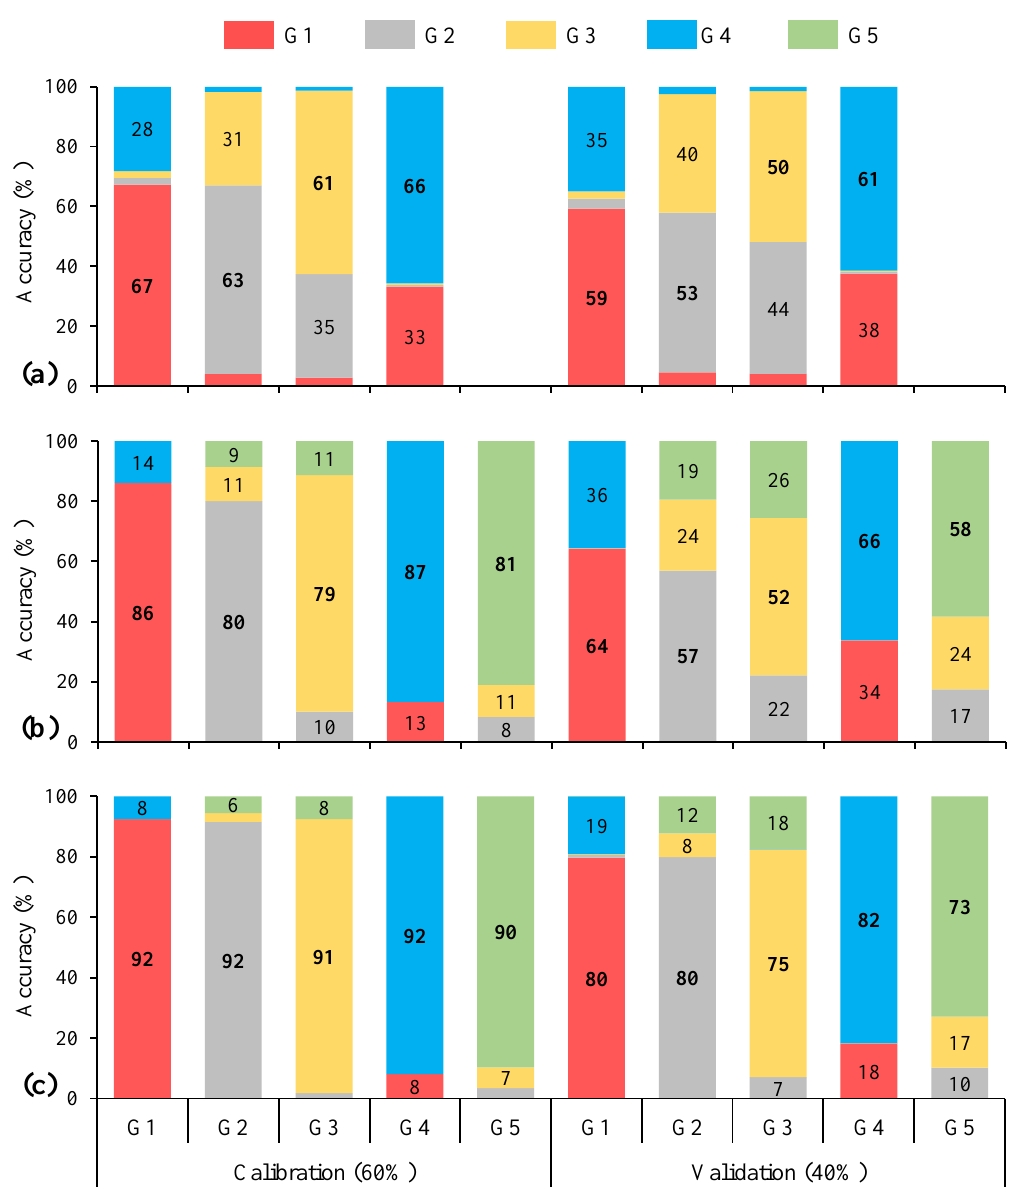
Figure 10. Linear discriminant analysis of Embrapa 2016/2017 ( a ), Embrapa 2017/2018 ( b ), and Embrapa 2018/2019 [I] ( c ) spectral datasets: percentage of accuracy in the spectral classification of each genotype (bar) relative to all genotypes (colors within the bar) for calibration and validation approaches.